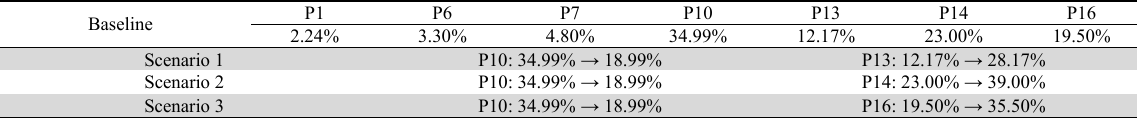
Sensitivity analysis experiment designs.